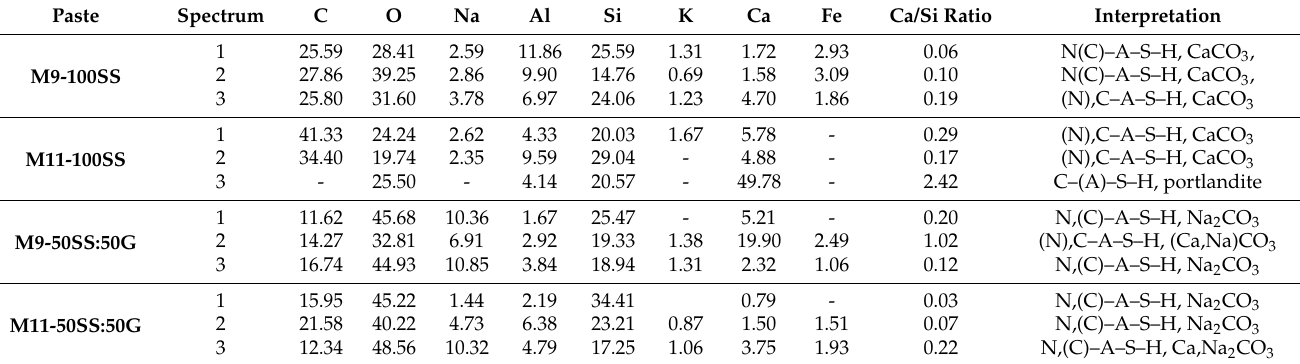
Table 3. EDS for M9 y M11 with 100SS and 50SS:50G: Composition (wt.%) and Interpretation.